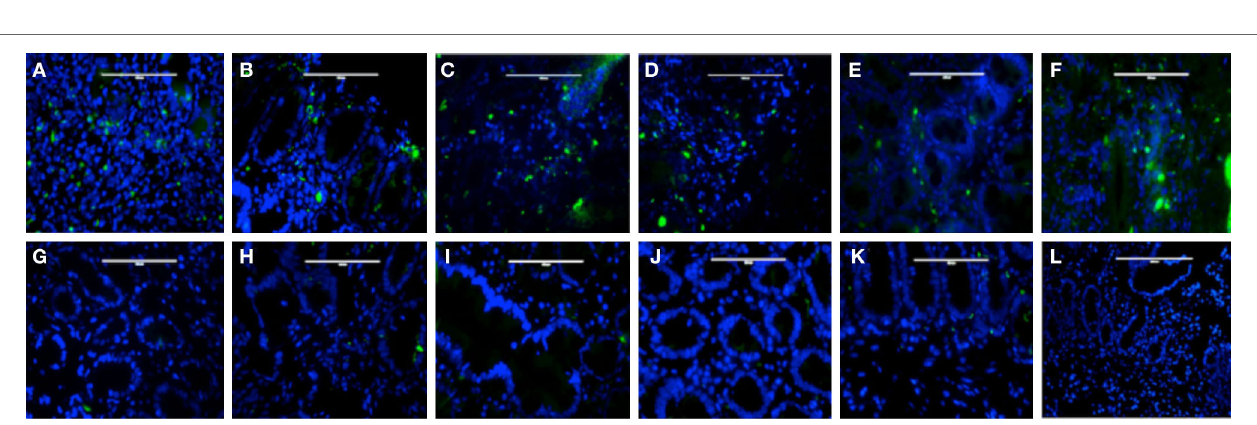
FigUre 2 | infiltration of plasmacytoid dendritic cells in duodenum biopsies of six subjects with hiV/aiDs (a–F) and six non-hiV subjects who were evaluated for gastritis (g–l) . Biopsies were probed with antibodies FITC-anti-CD303 monoclonal antibody (green) and nucleus localization was determined by TOPO3 staining (blue). Bar represents 20 μ m.